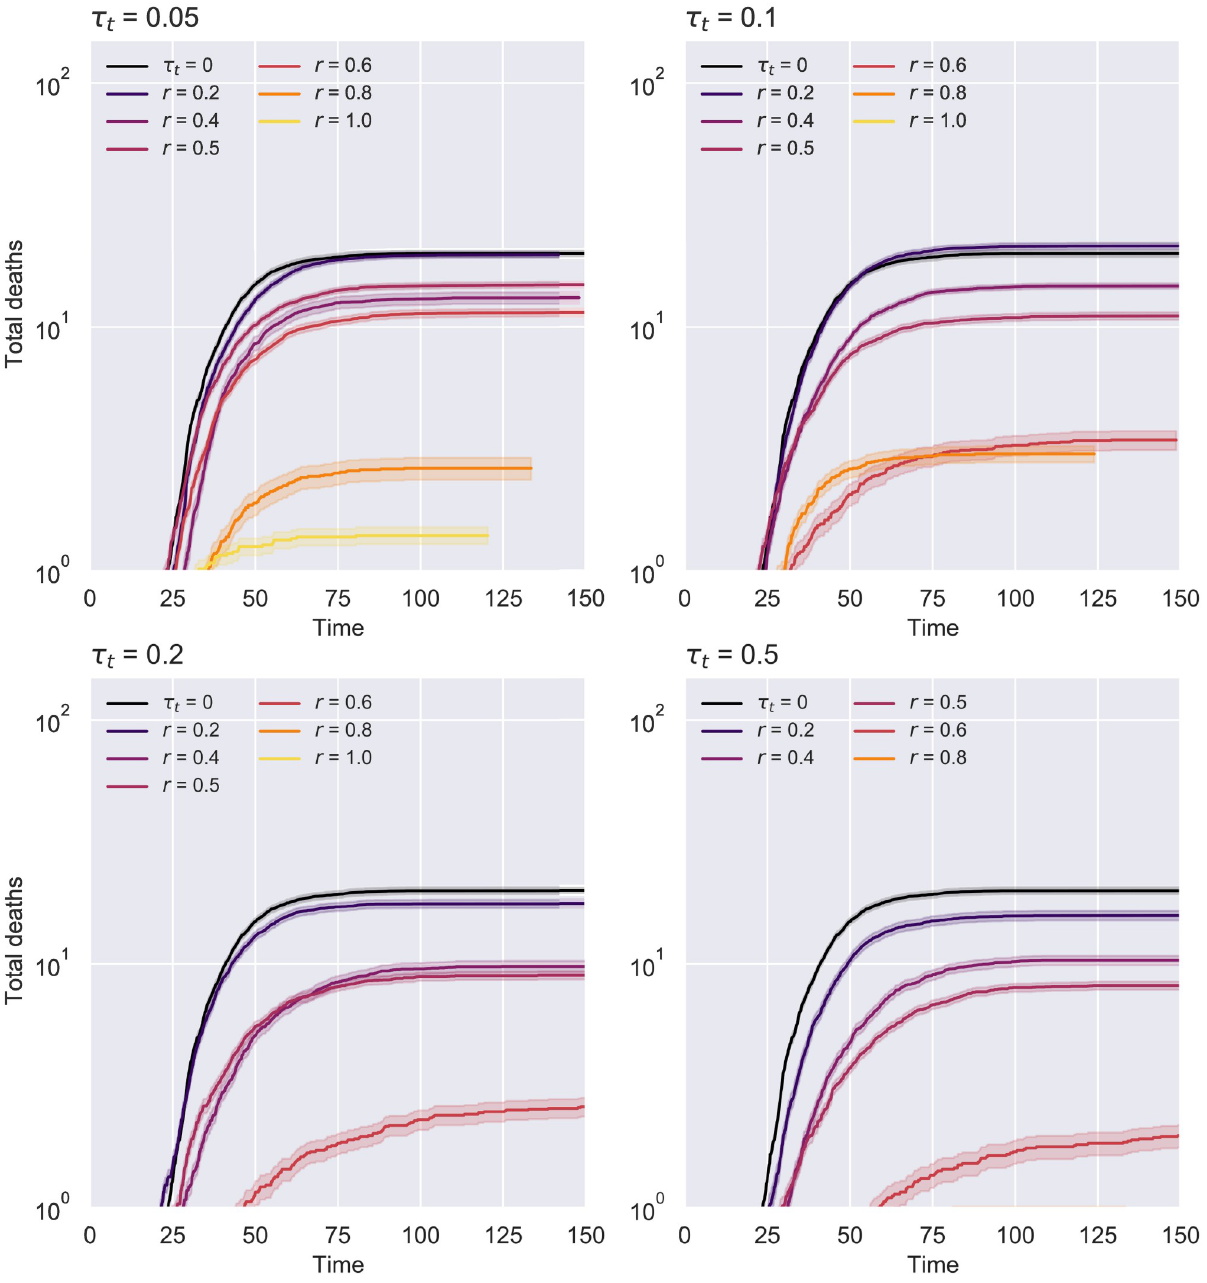
Fig 11. ER network—Total deaths over time for τ r = 0.1 N = 1000 and K = 20. The 95% confidence intervals resulted from 750 runs are displayed = 0) is colored in black. around each line. The case with no contact tracing ( τ t